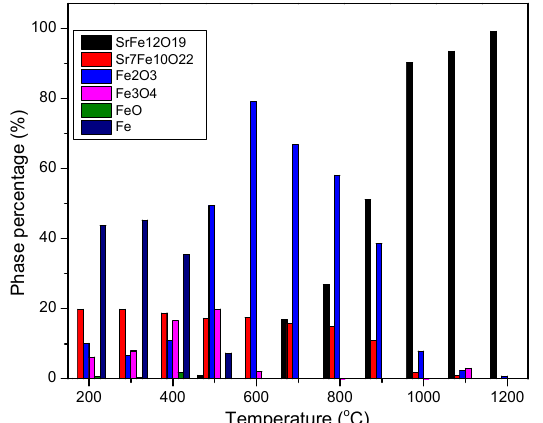
Figure 10. Phase percentages in the gas heat treated samples, re ‐ calcined at different temperatures.